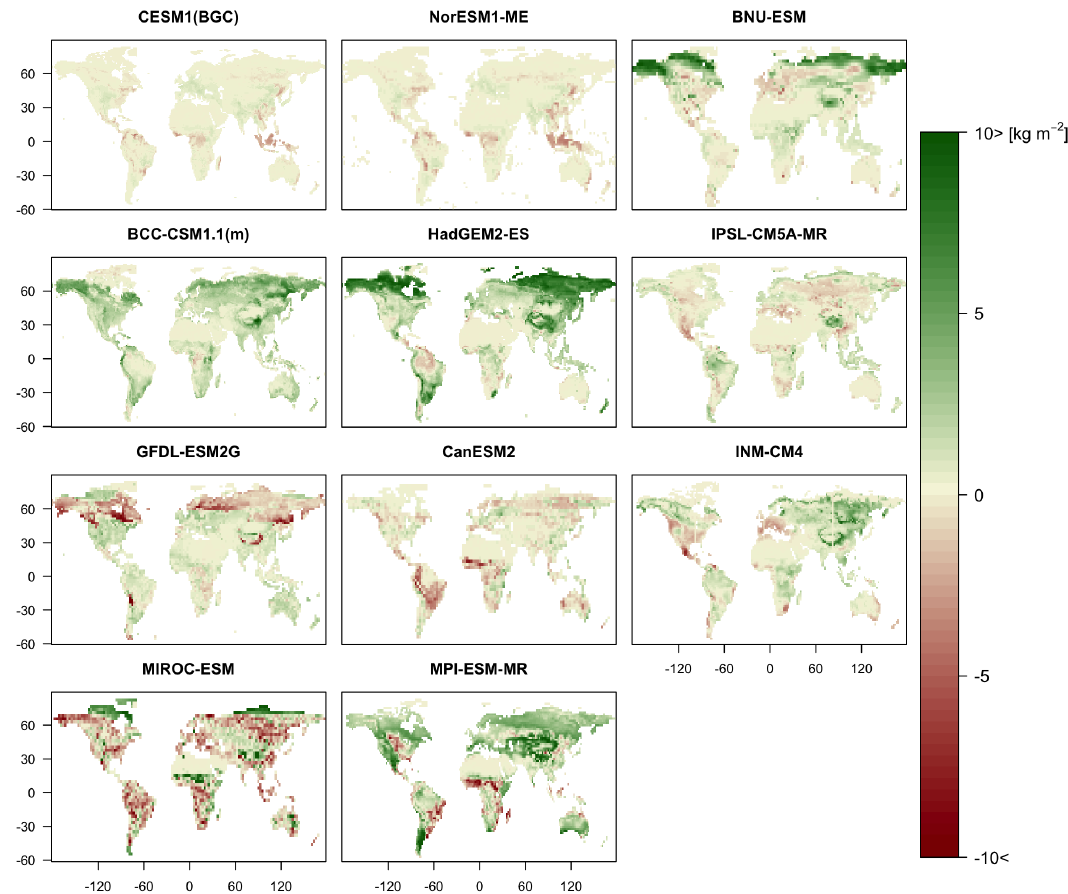
Fig. 2. Absolute change in soil carbon density (kgm − 2 ) over the 21st century for all models (difference in 10-year means; 2090–2099 minus